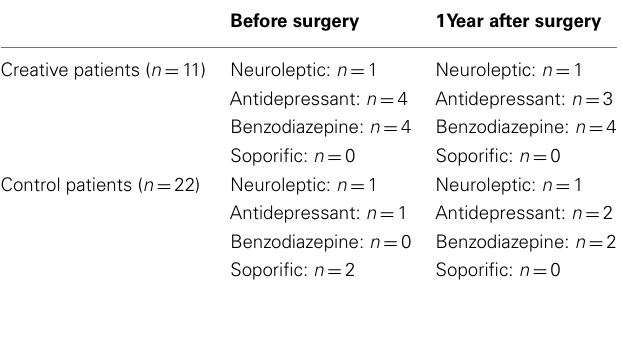
Table 2 | Psychotropic sedative drugs.